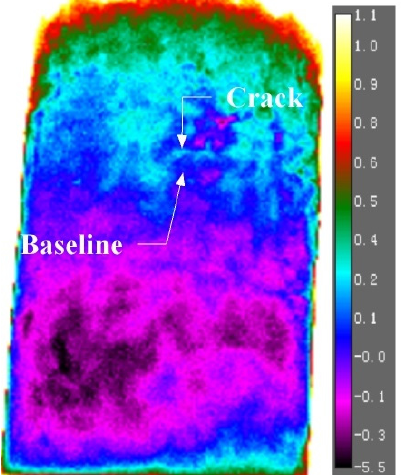
Sensors 2022 , 22 , x FOR PEER REVIEW Figure 6. Temperature profile of clay specimen (unit of scale bar is in °C). Figure 6. Temperature profile of clay specimen (unit of scale bar is in °C). Figure 6. Temperature profile of clay specimen (unit of scale bar is in ◦ C).